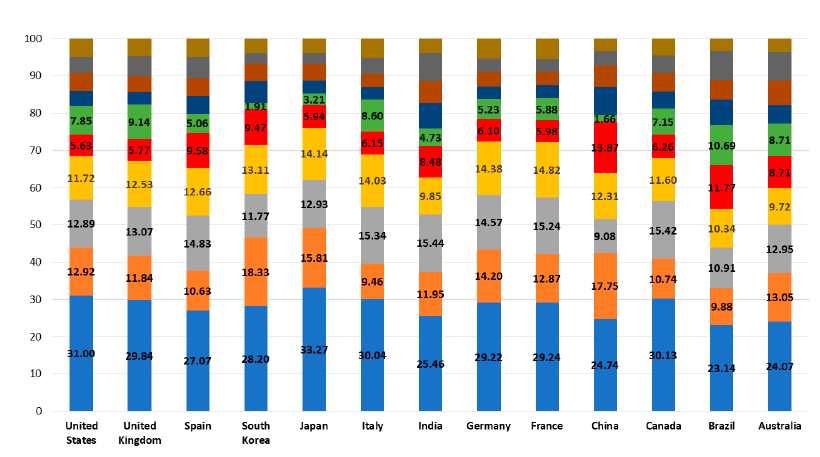
Figure 6. Distribution by scientific categories according to countries.